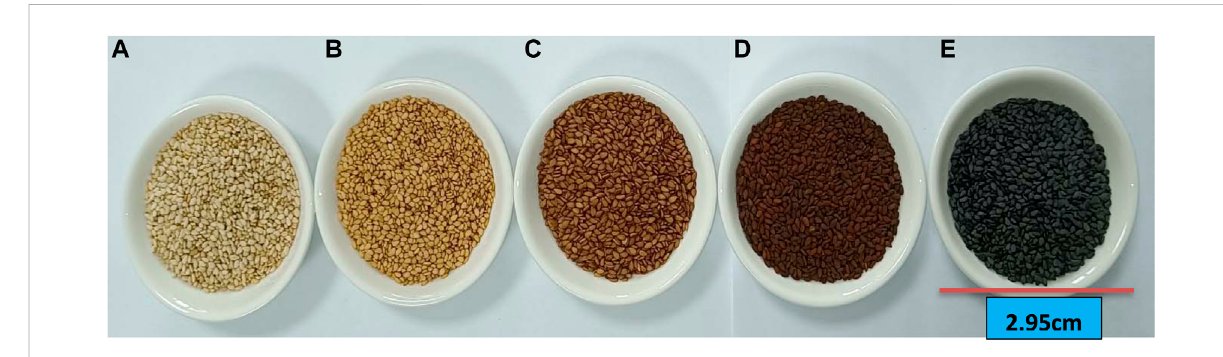
FIGURE 6 Different seed coat colors of sesame. (A) White. (B) Yellow. (C) Light brown color. (D) Brown. (E) Black.